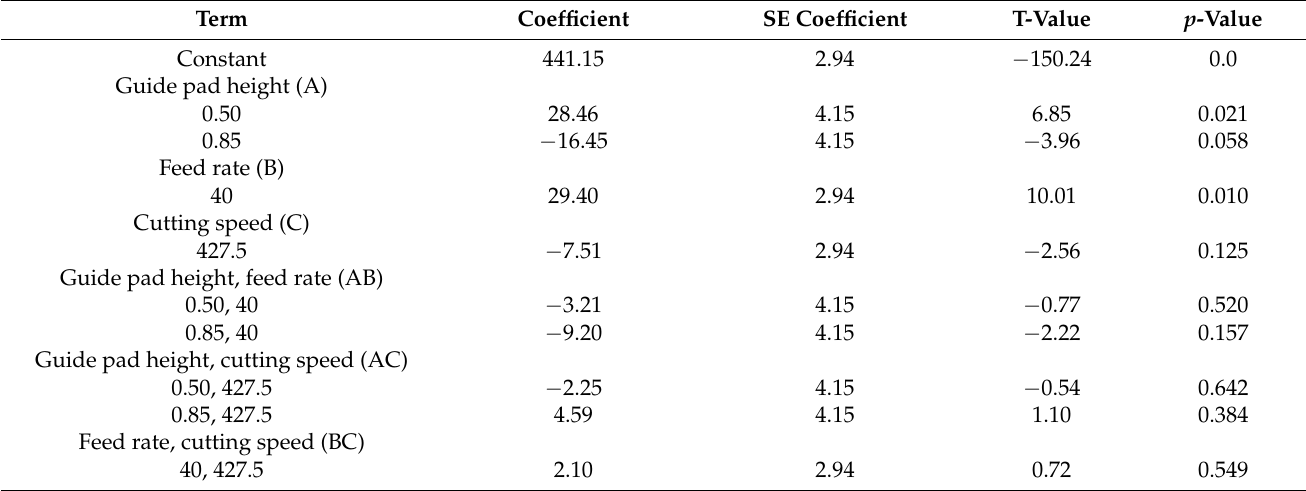
Table 9. Estimated effects and coefficients for the residual